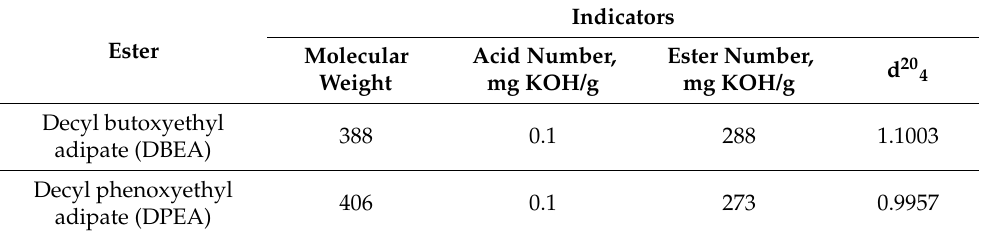
Table 1. Physicochemical properties of unsymmetrical esters of adipic acid.